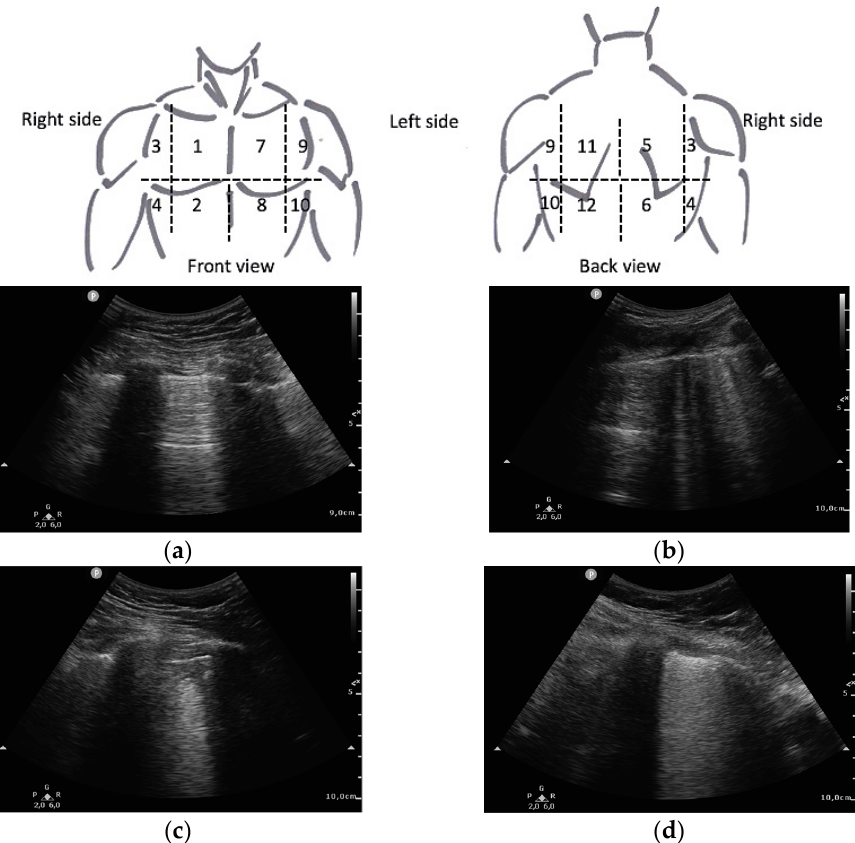
Figure 1. Lung areas distribution and LUS score as described by Soldati et al. [7]: ( a ) 0 points (normal A-lines pattern); ( b ) 1 point (>3 B-lines); ( c ) 2 points (subpleural consolidation); ( d ) 3 points (pulmonary consolidation or “with lung”).